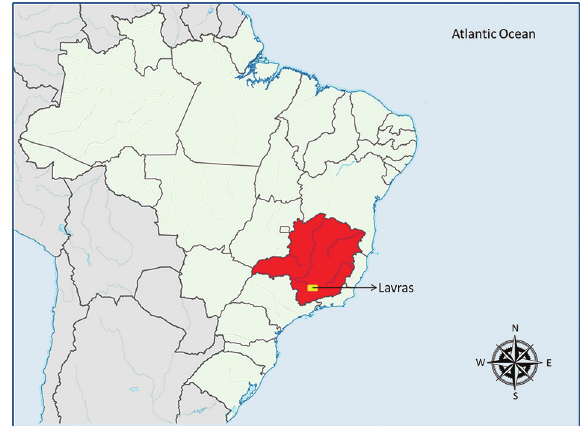
Figure 1. Location of the municipality of Lavras, Minas Gerais,